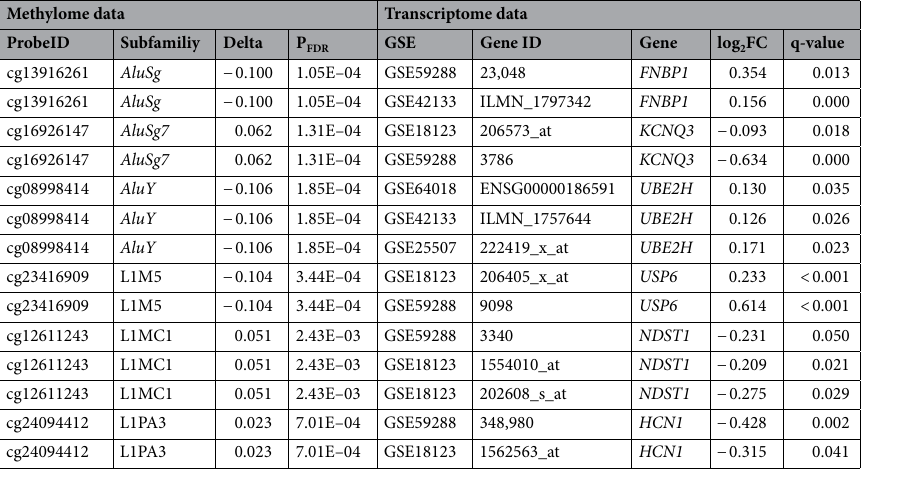
Table 1. Utilized gene expression microarrays/RNA-sequencing for the differential gene expression analysis of the target genes of heterogeneous